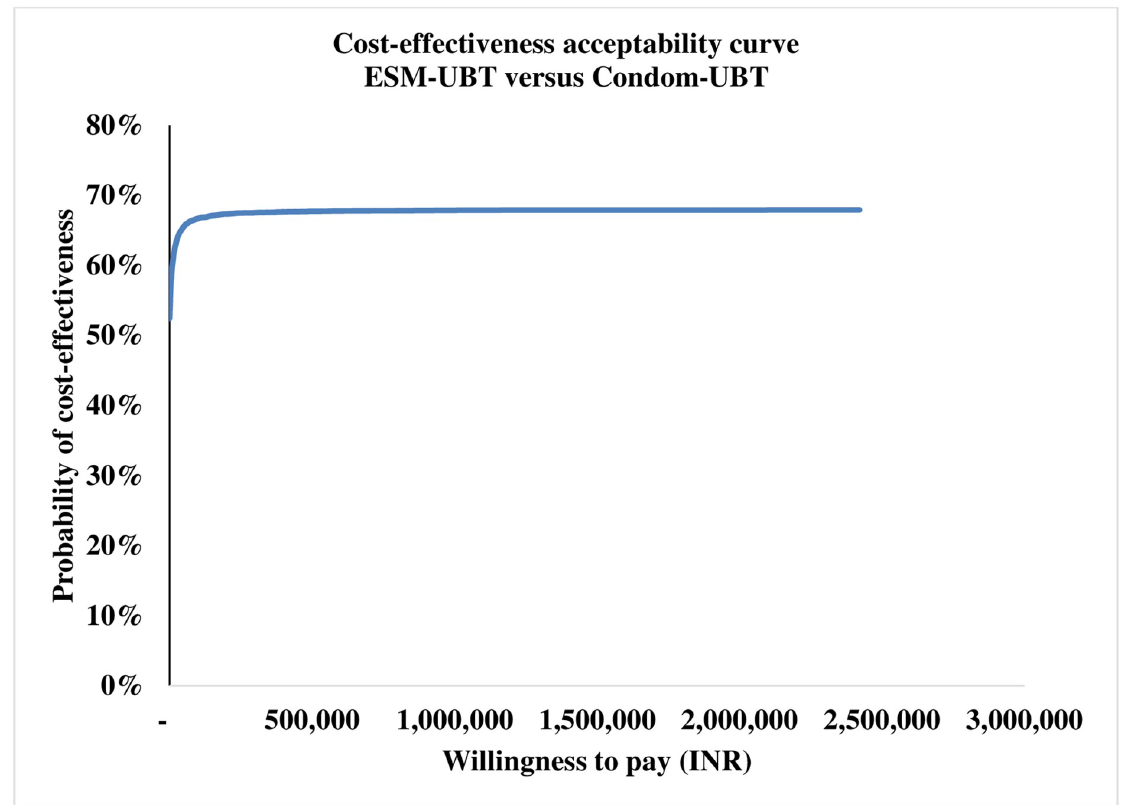
Fig 6. Cost-effectiveness acceptability curve for ESM-UBT versus condom-UBT comparison.